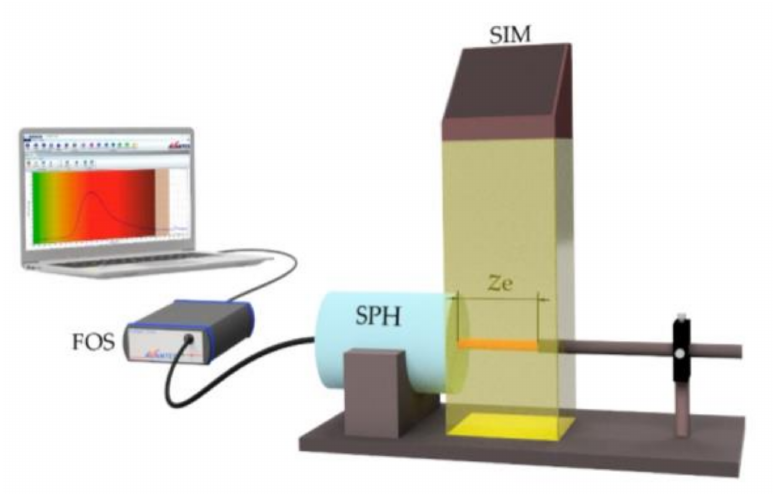
Figure 2. Illustration of the experimental set-up employed for the characterization of cylindrical LSCs using a solar-simulator. Legend: SIM: Solar-simulator; SPH: Integrating sphere; FOS: fiber-optic spectrometer. z e represents the illuminated fiber length. The non-excited fiber length up to the detector z ne is